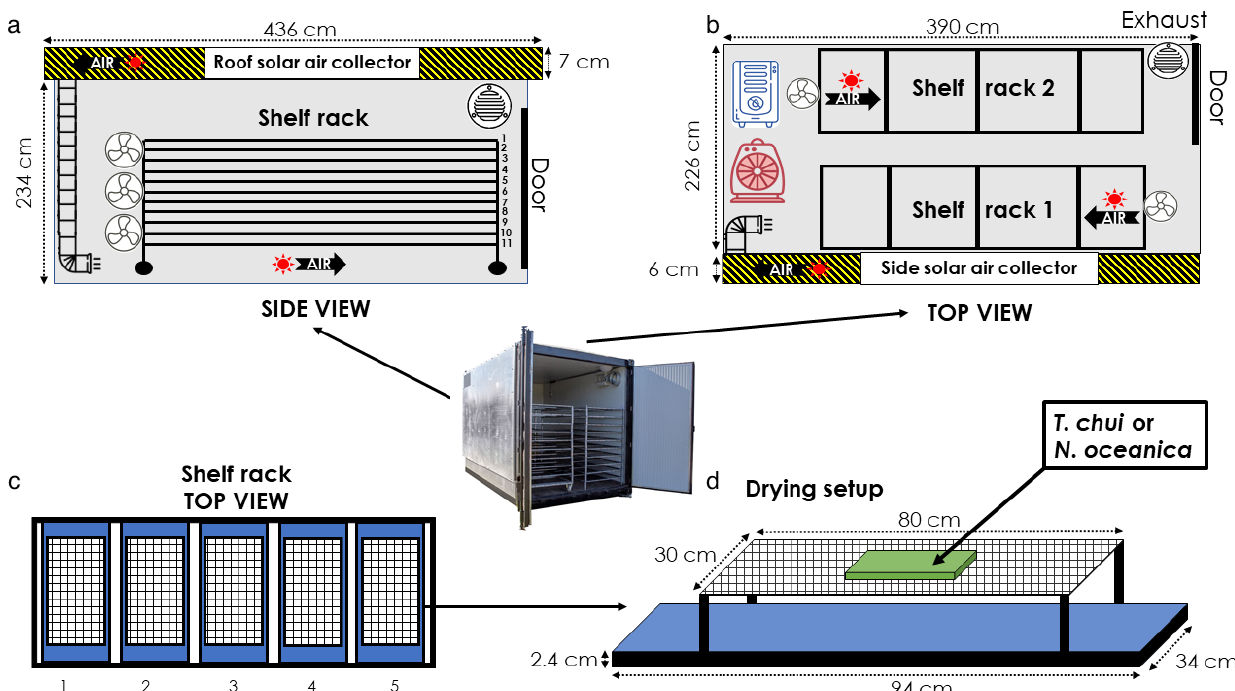
Figure 1. Technical diagram of the solar dryer and the experimental setup: solar drier side view ( a ), solar drier top view ( b ), top view of the shelf rack ( c ), and drying setup scheme ( d ). Experimental Setup